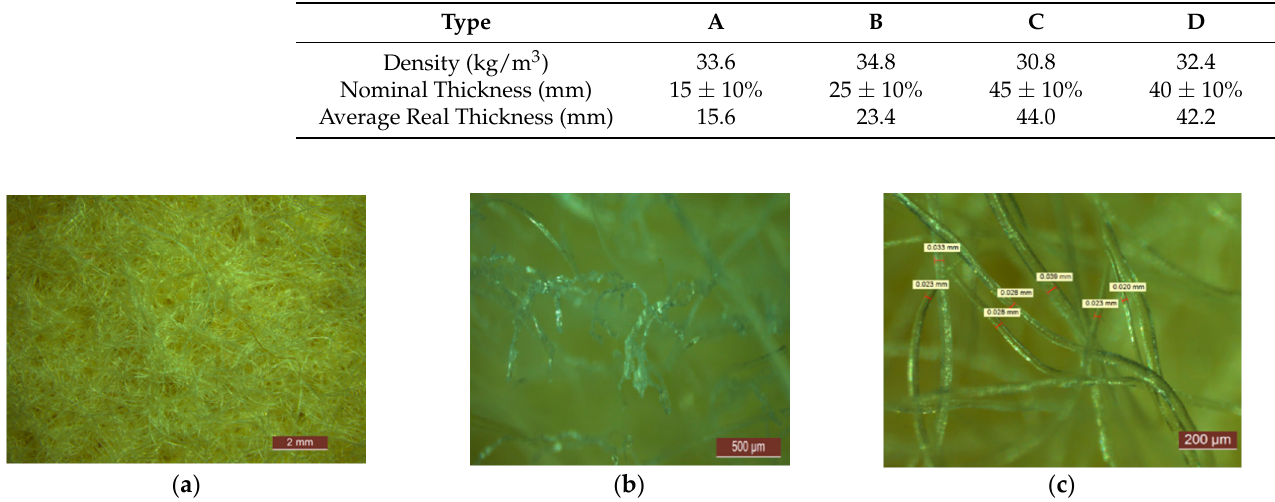
Figure 2. Microscopic analysis of sheep wool thermal-insulating mattresses: ( a ) 1×-overview; ( b ) 5×-identification of the thermal-sealing area; ( c ) 8×-analysis of the thickness of the wool thread.